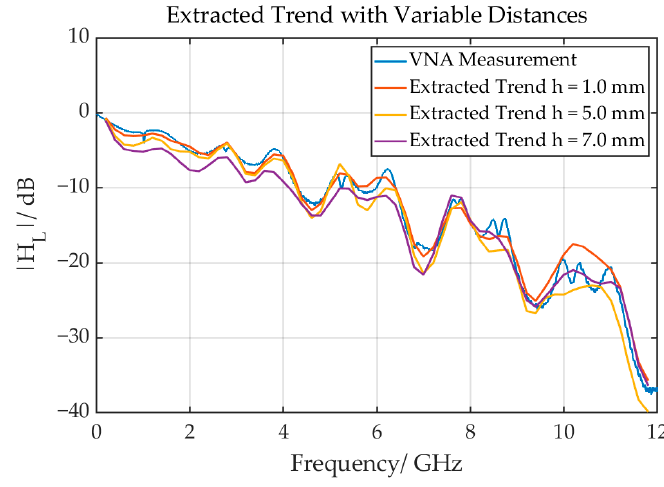
Figure 16. The transmission characteristic extraction at 1 mm, 5 mm, and 7 mm distances.